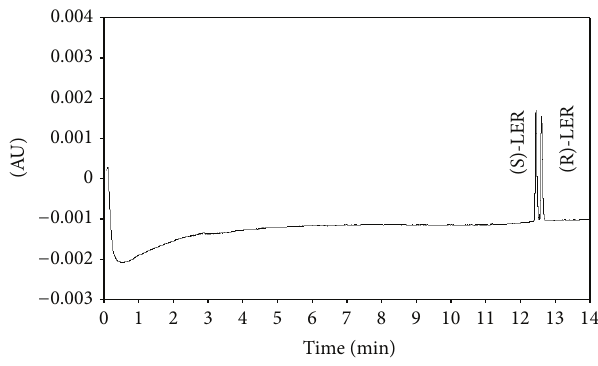
Figure 4: Electropherogram of migration order of LER enan- tiomers. Electrophoretic conditions: fused silica capillary of 50 𝜇 m (id), 50 cm effective length, and sodium acetate buffer 200 mmol/L,